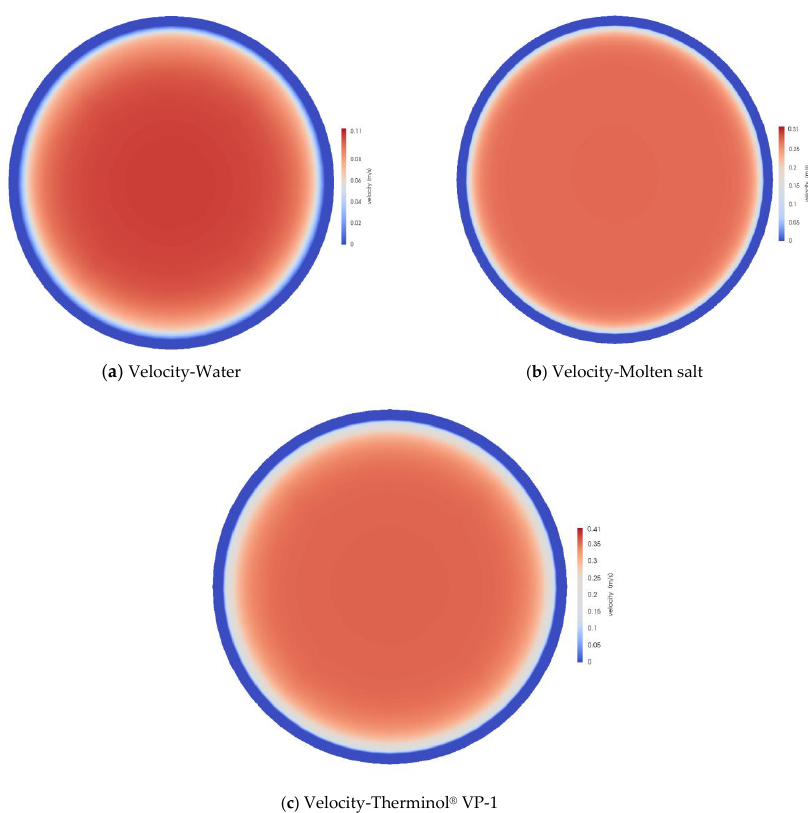
Figure 12. Velocity contours of all fluids at the smallest inlet temperatures. Energies 2020 , 13 , x FOR PEER REVIEW